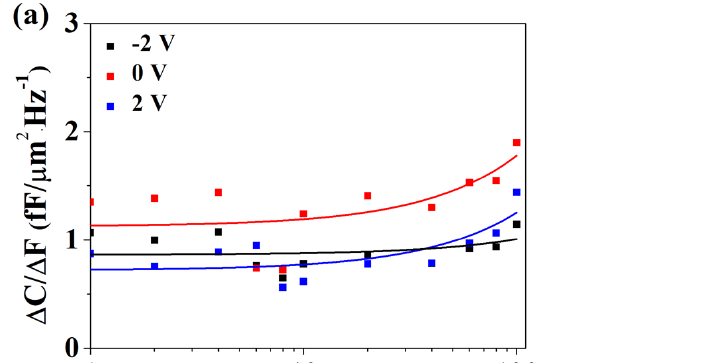
Figure 6. ( a ) Current power spectral density ( S I ) as a function of current density ( J ) at f = 10 Hz for the fabricated MFM capacitor. The dashed line indicates J 2 . ( b ) Oxide trap density ( N t ) versus voltage extracted from S I measurements.